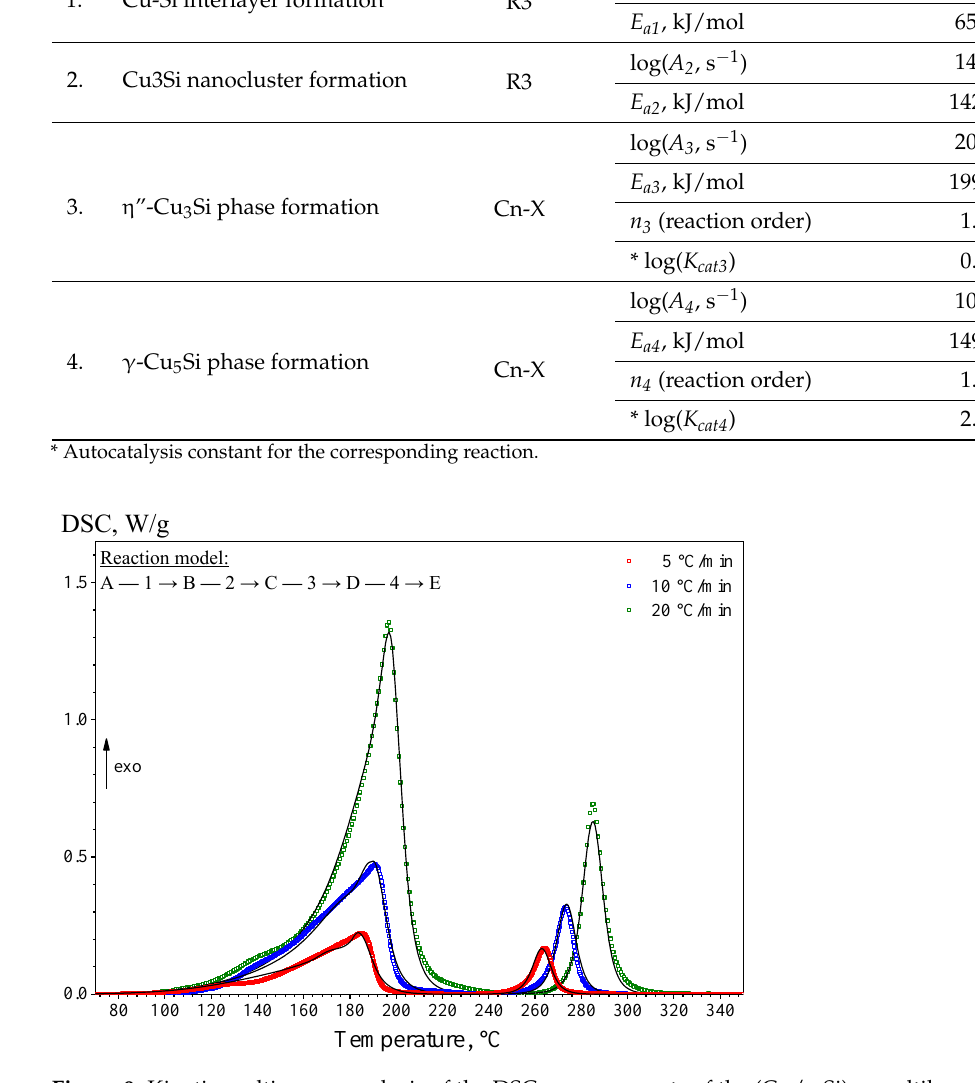
Figure 9. Kinetic multi-curve analysis of the DSC measurements of the (Cu/a-Si) 30 multilayer films: signs — measured; lines — calculated. Table 7. Apparent activation energy, pre-exponential factor, reaction order, and autocatalysis rate constant of each transformation in the (Cu/a-Si) 30 multilayer films.